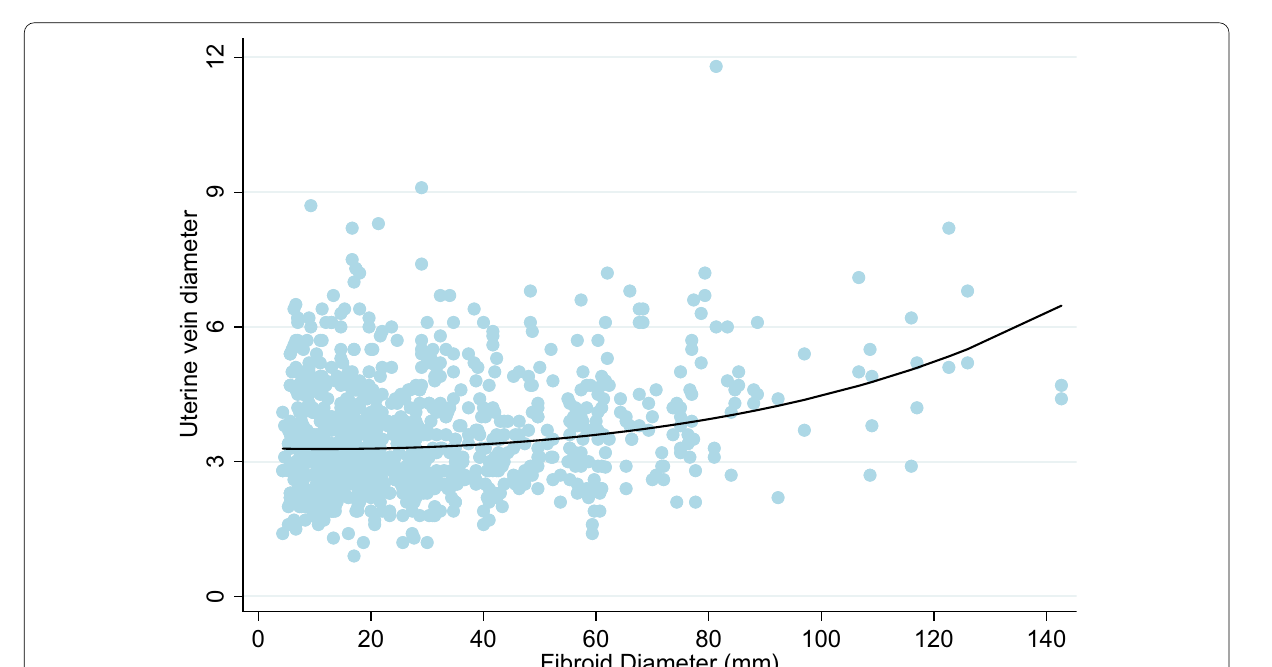
Fig. 4 The effect of age on uterine vein diameter (mm)